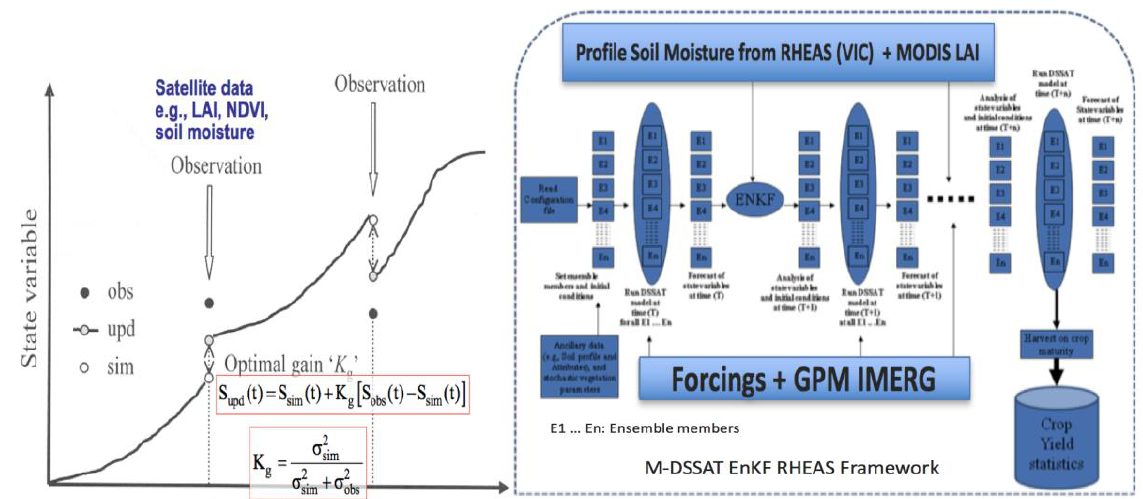
Figure 5 : M-DSSAT crop model of the RHEAS framework. It is capable of 50 ensembles (E in the figure), optimal to capture the variability in agricultural system within an administrative unit